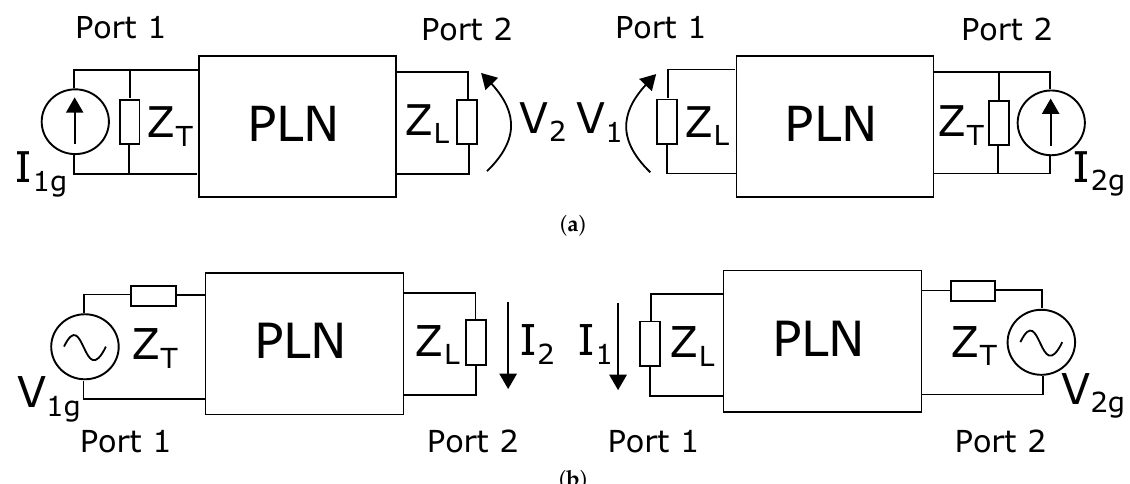
Figure 3. Trans-resistance ( a ) and trans-conductance ( b ) communication schemes in a power line network (PLN), with the generator either on Port 1 or on Port